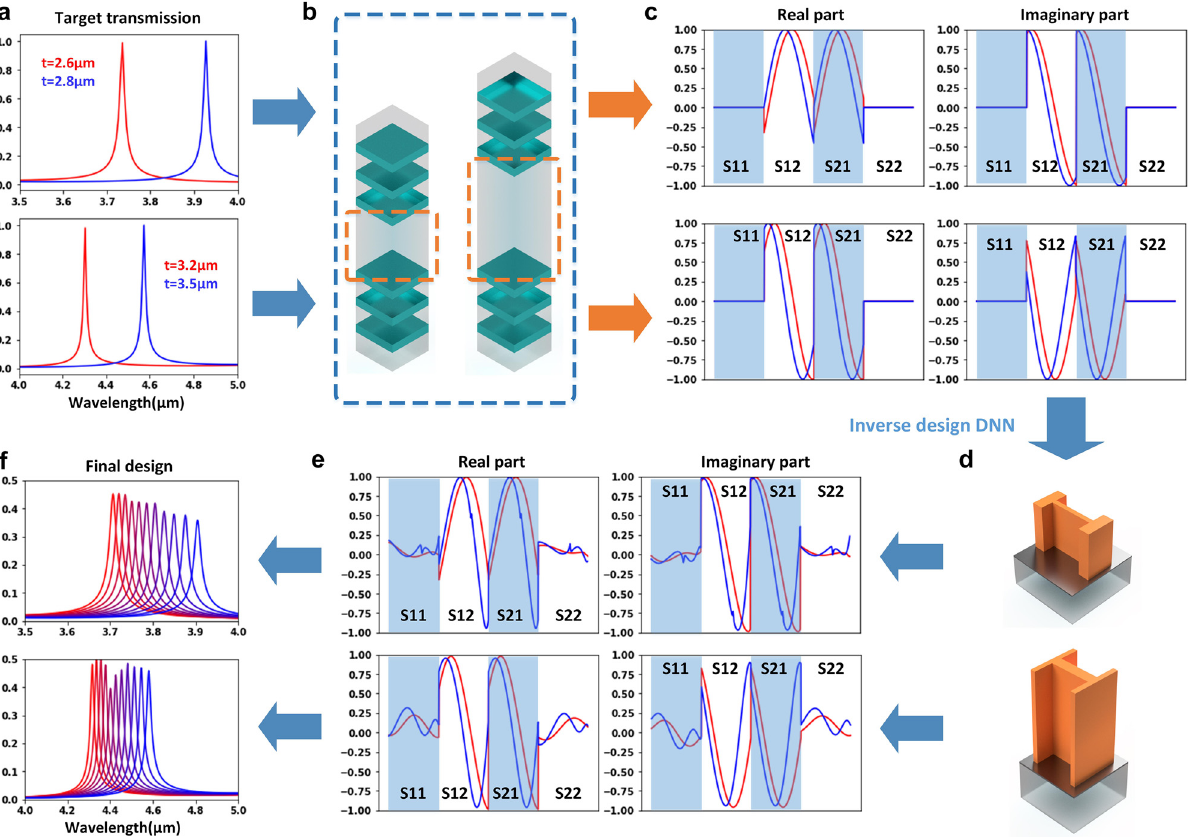
Figure 5: Design examples with the inverse DNN. (a) Target transmission spectra. The positions of the two peaks (red represents target response in the amorphous state, blue represents target response in the crystalline state), along with the tuning range were defined. (b) The distance between DBRs (in both states) was calculated based on the target spectrum. (c) Corresponding S -matrices (amplitude vs. frequency, 60–100 THz) were calculated and fed into the inverse DNN. (d) Design parameters generated by the inverse DNN. (e) S -matrices (amplitude vs. frequency, 60–100 THz) of the generated designs showing in (d). (f) Transmission spectra of the final design. Red and blue curves represent the transmission of the filter design in the amorphous and the fully crystalline state. The other 9 curves represent the responses of the design in intermediate states between amorphous and fully